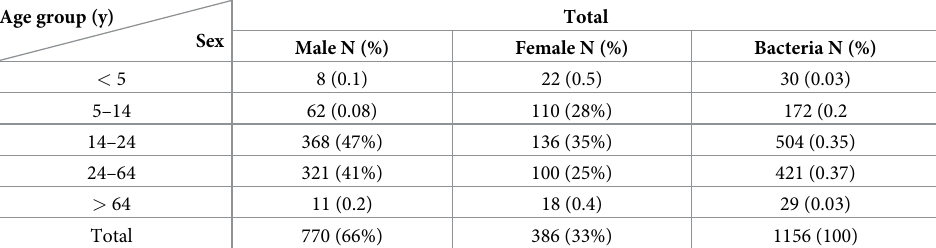
Table 1. Age and sex distribution of patients with bacterial isolates.